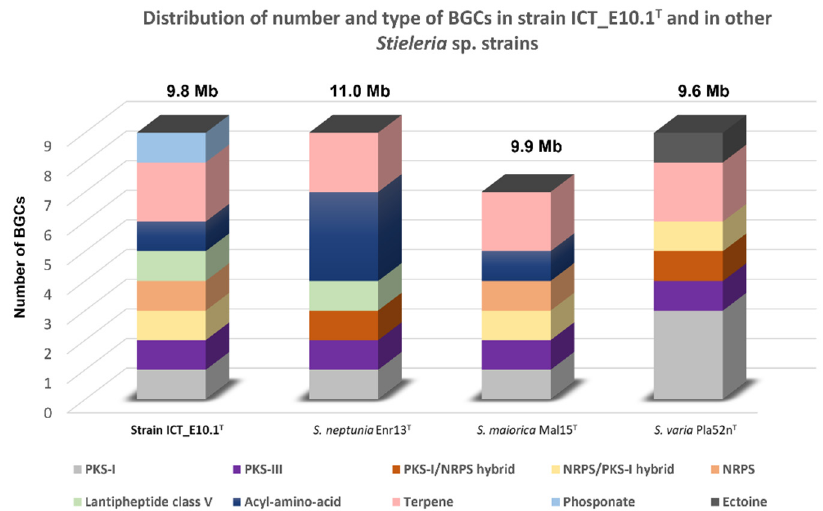
Figure 6. Distribution of number and structural types of BGCs putatively found in strain ICT_E10.1 T and in its closest relatives S. maiorica Mal15 T , S. neptunia Enr13 T and S. varia Pla52n T for comparison, evidencing the content differences between strains. The genome size of each strain was additionally added above each bar.